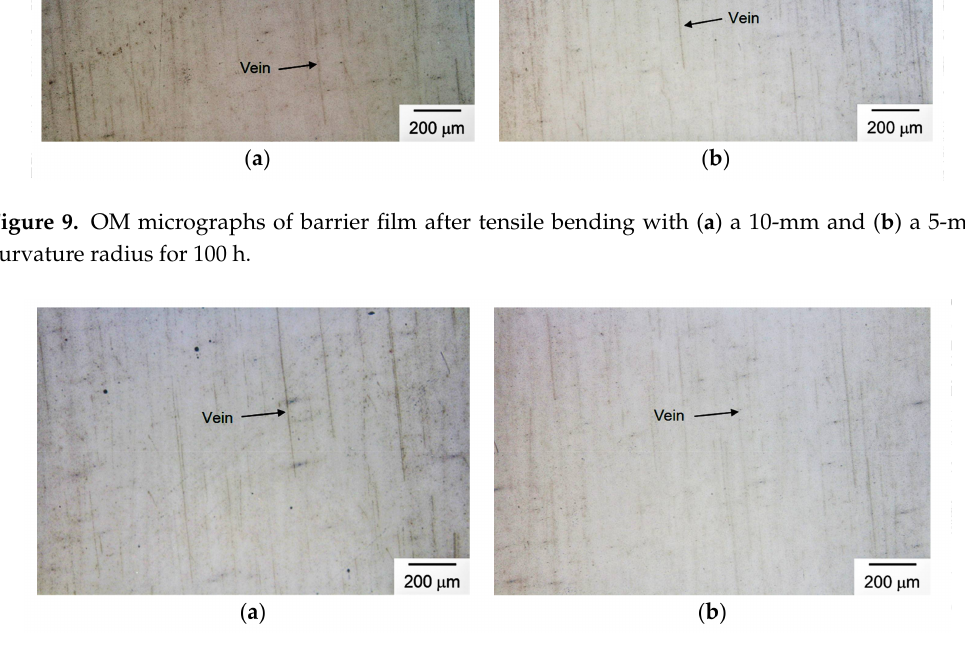
Figure 10. OM micrographs of barrier film after compressive bending with ( a ) a 10-mm and ( b ) a 5-mm curvature radius for 1000